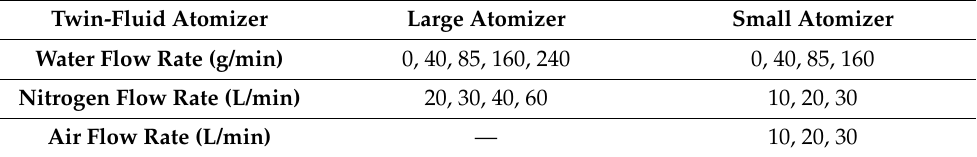
Table 1. Flow rate conditions of large and small atomizers for fire extinguishment.